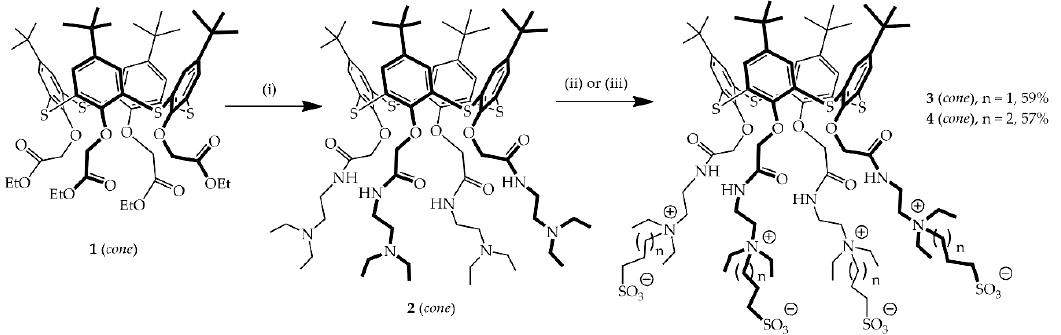
Table 1. In vitro cytotoxic effects ( µ M) of sulfobetaine derivatives 3 , 4